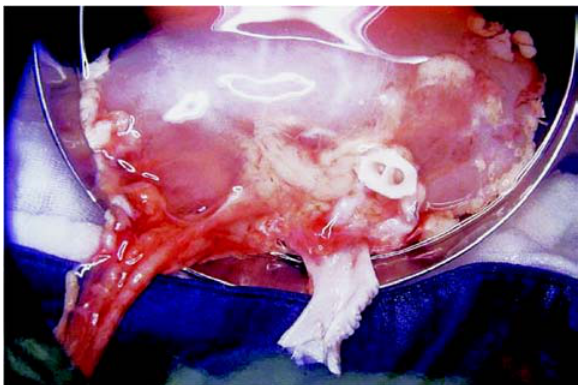
Figure 3 – Bench surgery. Right vein elongated (V), and patch of the aorta (A) attached to 2 renal arteries.